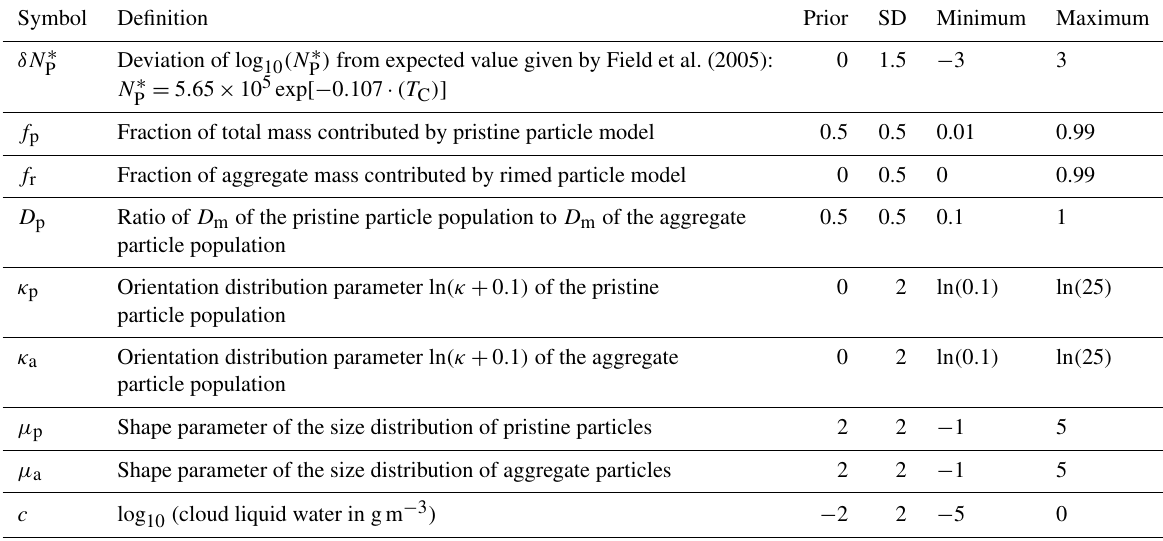
Table 5. Names, definitions, a priori value, standard deviation, and allowed ranges of quantities in the state vector (Eq. 13). Note that some quantities are retrieved in logarithmic space to accommodate lognormal distributions and/or to linearize the forward model. SD: standard